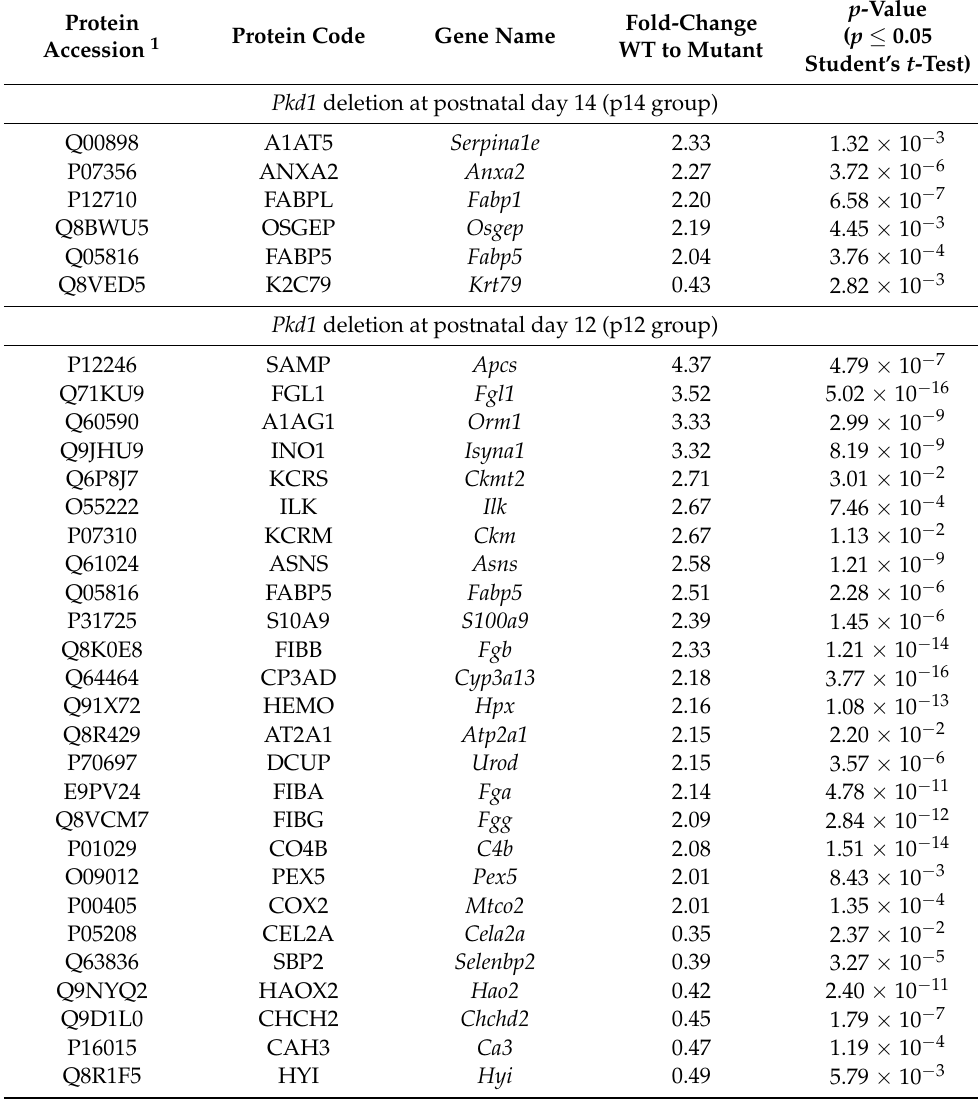
Table 1. List of proteins that presented an abundance with two-fold up-regulated (>2 fold-change) or down-regulated (<0.5 fold-change) and a significant adjusted p -value (according to parametric Student’s t -test) comparing Wild Type and Mutant polycystic livers. Table shows the list corresponding to the results with inactivation of the Pkd1 gene at postnatal day 14 and 12. First, second and third columns represented the protein accession, protein code and gene name respectively. Fifth and sixth column represent the fold-change and p -value of quantitative SWATH